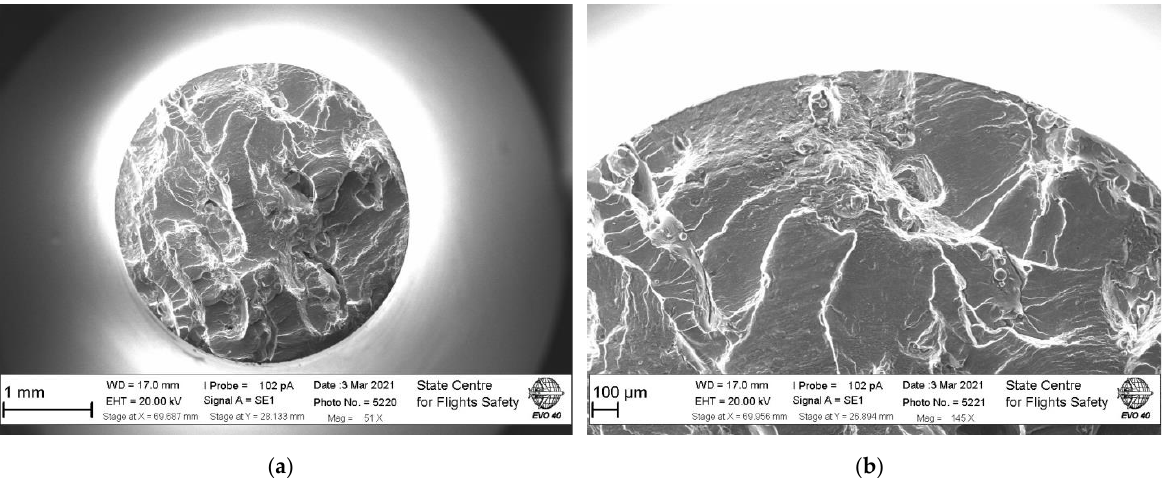
Figure 12. The typical fracture surface under VHCF loading of SLM aluminum alloy ( a ) and semi- ellipsoid crack initiated from the large pore ( b ).